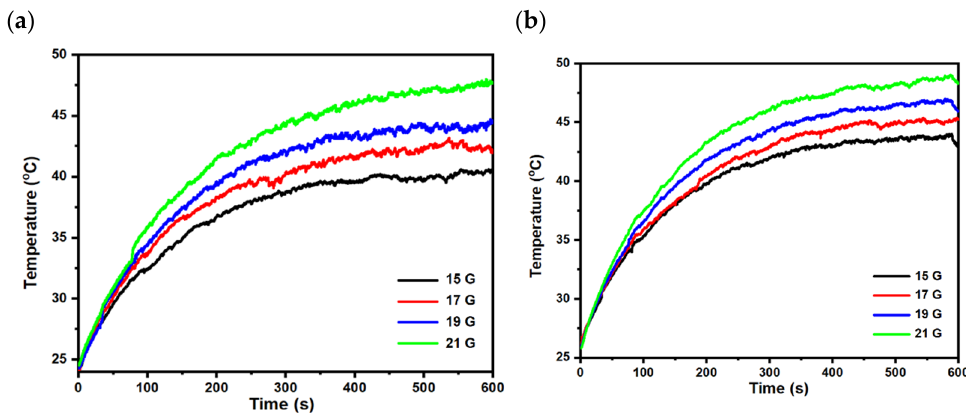
Figure 14. Temperature change in time for 15 mg mL − 1 ( a ) and 20 mg mL − 1 ( b ) for SPION/HAp under the AMF, where f = 540 kHz.